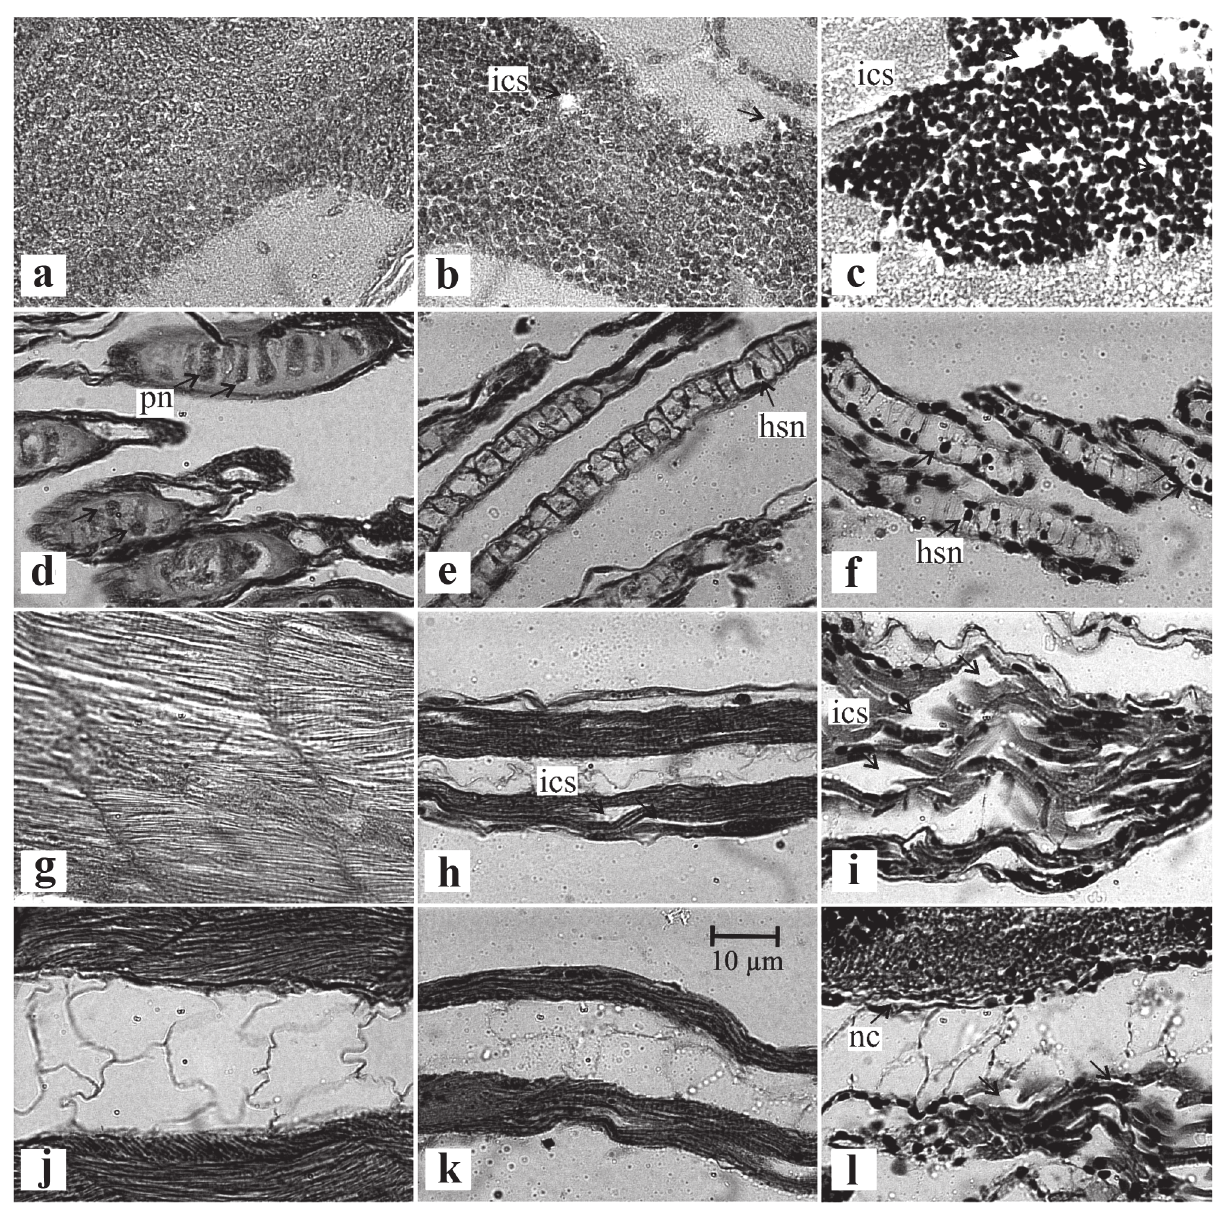
Fig. 4. Histological sections of Pagrus pagrus larvae, indicators of long term nutritional condition. Sagital section of 4 µm thick stained with Harris’s hematoxylin and eosin counterstain (H-E). ( a-c ) nervous system, ( d-f ) cartilage, ( g-i ) muscle, ( j-l ) notochord; left = fed larvae, middle = delayed fed larvae and right = starved. hsn: heavily stained nucleus, ics: inter-cellular space, nc: notochord contraction, pn: prominent nucleus. Scale bar indicates 10